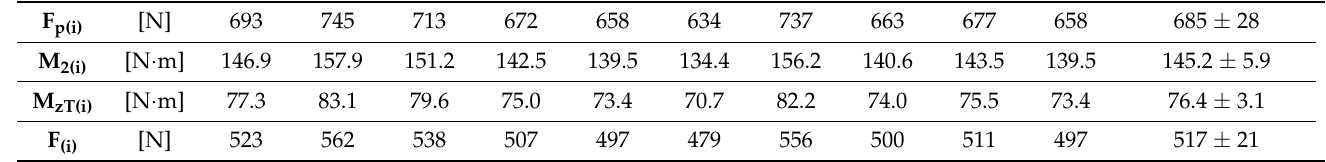
Theoretical torque magnitude M 2T [N·m] (Figure 3) acting on the shaft of the rope